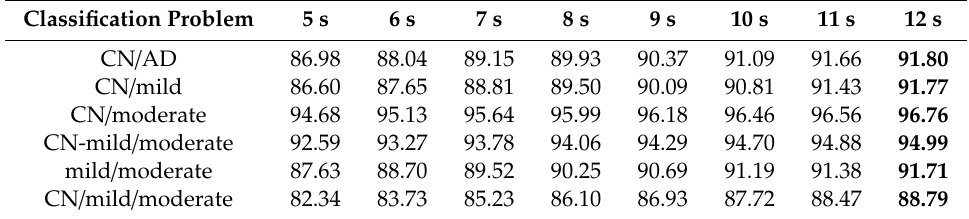
Table 3. The classification results in terms of the Accuracy (ACC) for each classification problem for 8 window lengths.